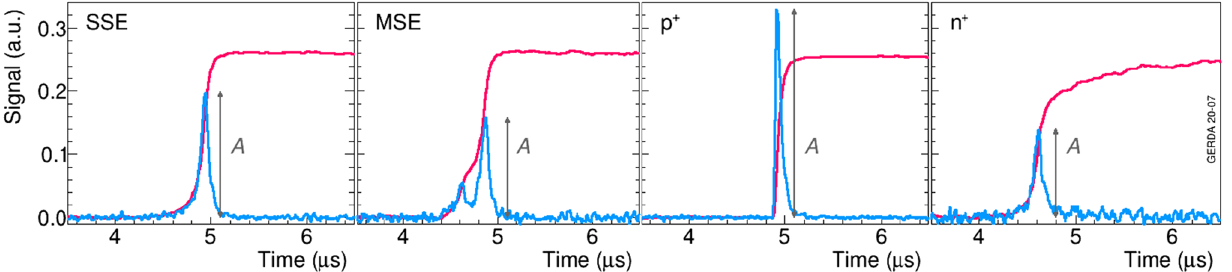
Fig. 2 Examples of different type of normalized charge pulses (red) along with the derived current pulses (blue) from a BEGe detector: single-site event, multi-site event, event near the p + contact and event near the n + contact with incomplete charge collection